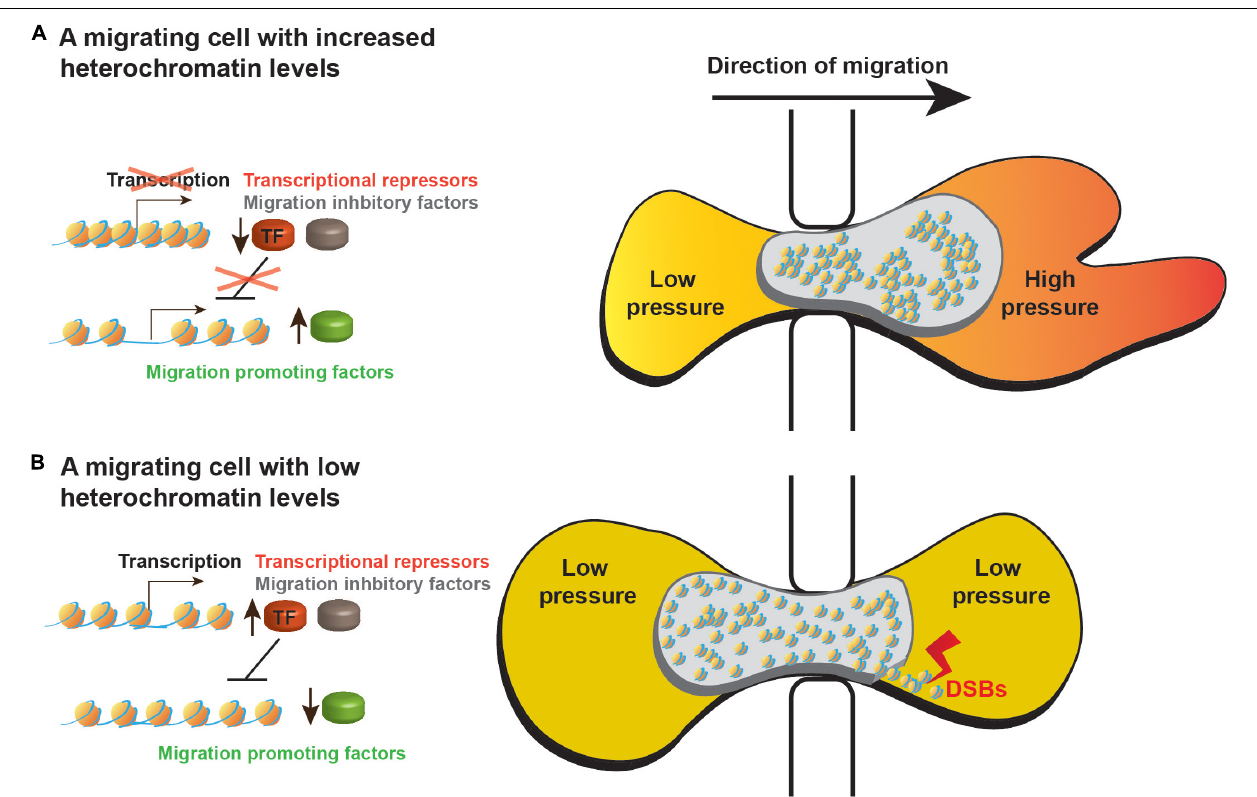
FIGURE 1 | A model of heterochromatin roles in migrating cells. Schematic representation of cells migrating through small pores while (A) increasing their heterochromatin levels or (B) leaving their heterochromatin levels low as before receiving the migration signals. Higher heterochromatin levels support better the migration process by the following mechanisms: (i) Heterochromatin-dependent stiffness of the nucleus leads to faster nuclear movement out of the restraining pore. (ii) Increased nuclear stiffness may help the actomyosin network to increase the intracellular pressure in the anterior of the cytoplasm to induce formation of lobopodial protrusions. (iii) Increased nuclear stiffness may protect the nucleus of mechanical insults, preventing nuclear envelope rupture and DNA damage such as double strand breaks (DSBs). (iv) Heterochromatin inhibits transcription of migration inhibitory factors (marked in gray) and of repressors of transcription (TF, marked in red) thus preventing transcriptional inhibition of migration promoting factors (marked in green). (v) Heterochromatin also prevents unnecessary transcriptional